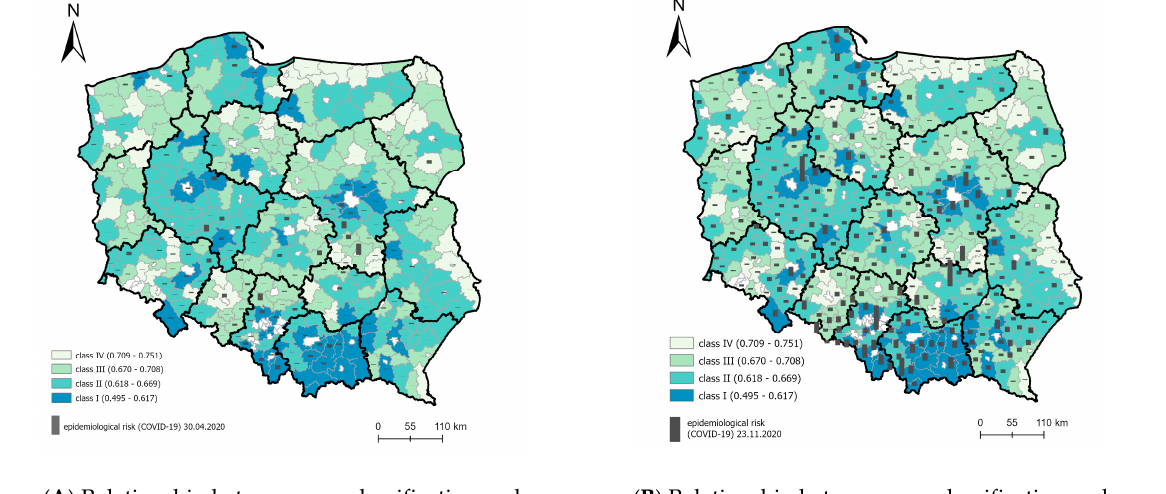
Table 2. Social interactions according to nature of factors and type of relations (Pearson’s correlation). Factor